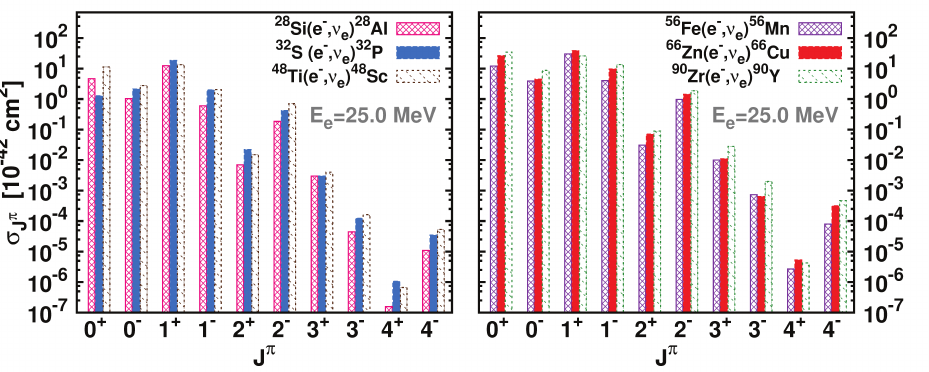
Figure 4. Partial e − -capture cross sections originating from different multipole transitions for all